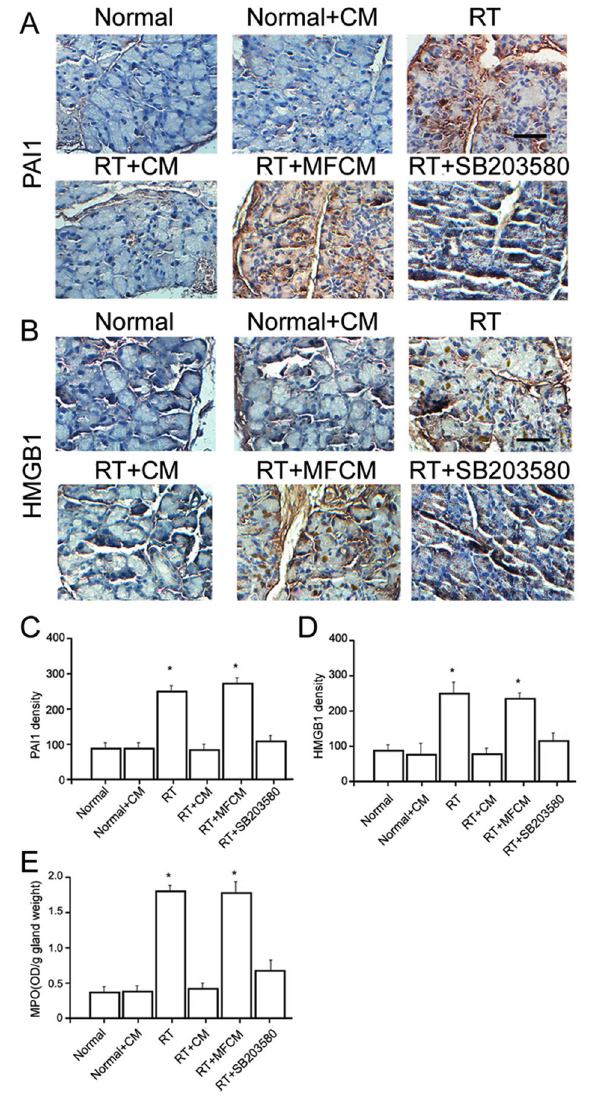
Figure 3. iPSC-CM suppressed the RILI-associated in fl ammatory response. ( A ) Immunohistochemical staining for PAI1 in iPSC-CM treated RILI and normal mouse lacrimal glands. Scale bar = 25 µm; ( B ) Immunohistochemical staining for HMGB1 in iPSC-CM treated RILI and normal mouse lacrimal glands. Scale bar = 25 µm; ( C , D ) Quanti fi cation of the mean density of immunohistochemical staining of